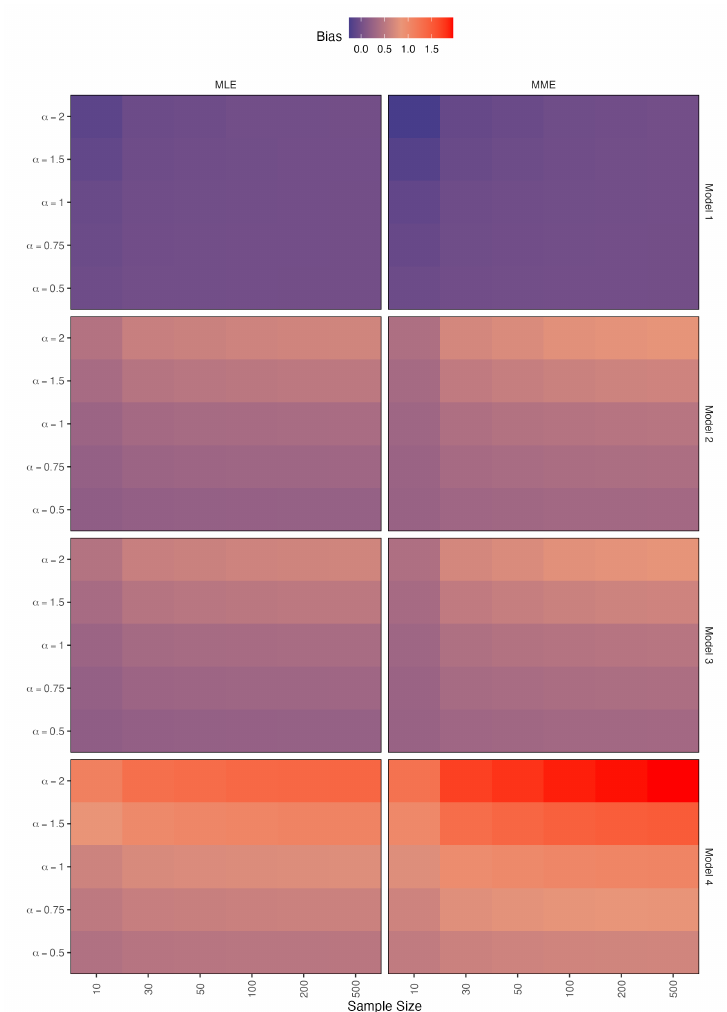
Figure 5. Simulated biases for the estimators of α